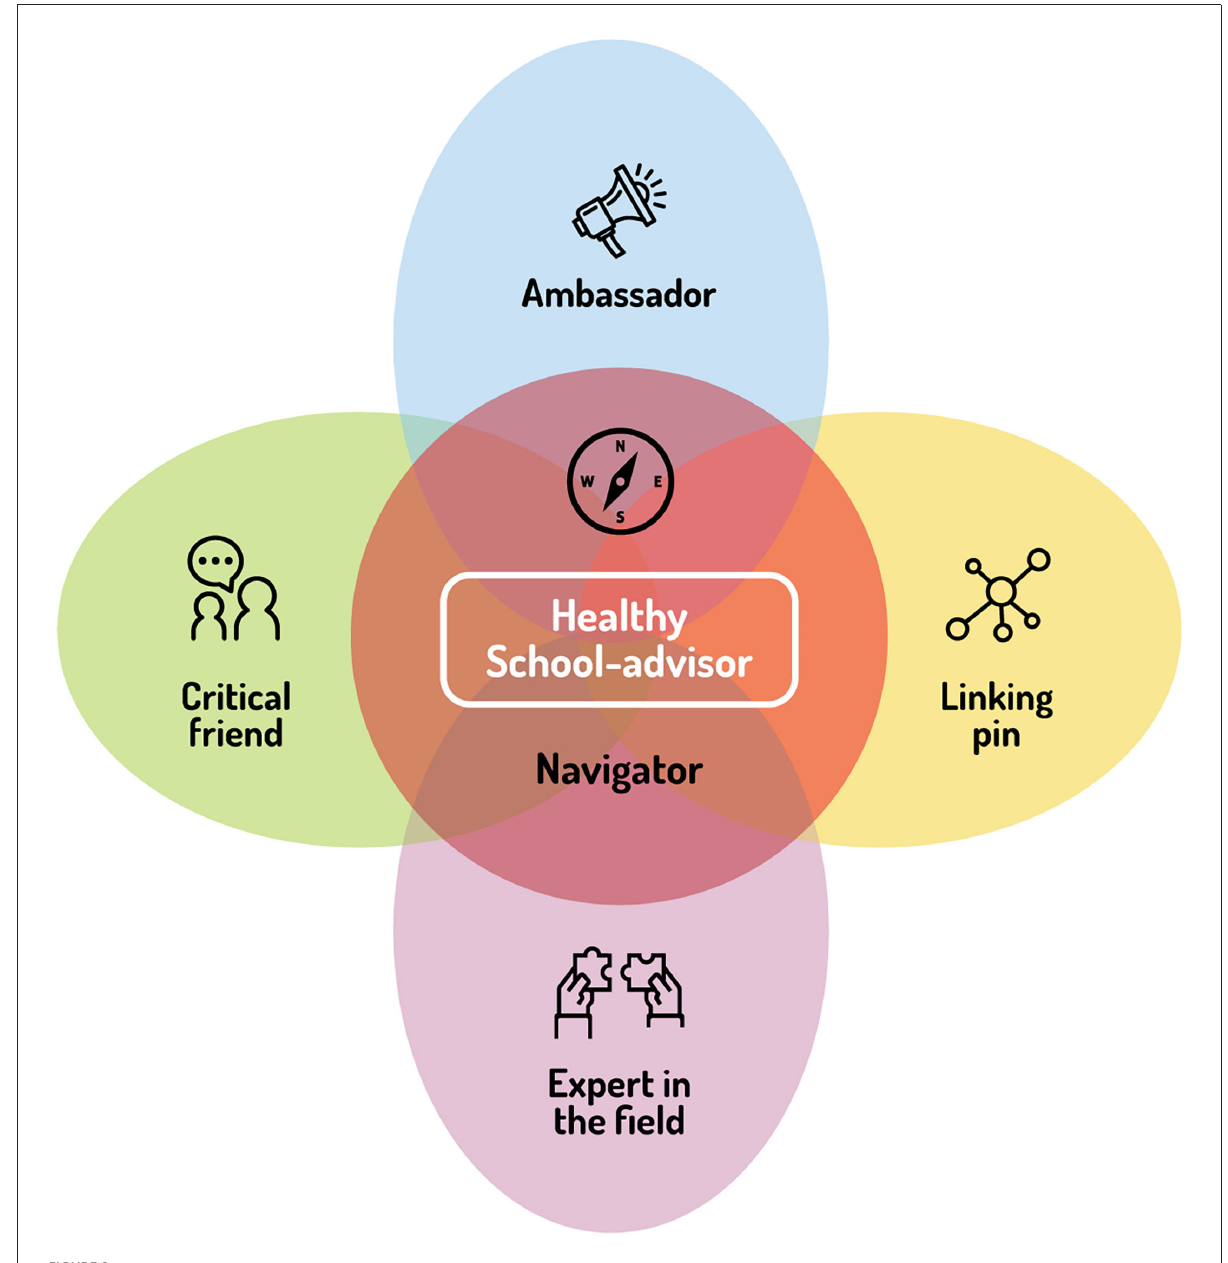
FIGURE2 The five roles of a Healthy